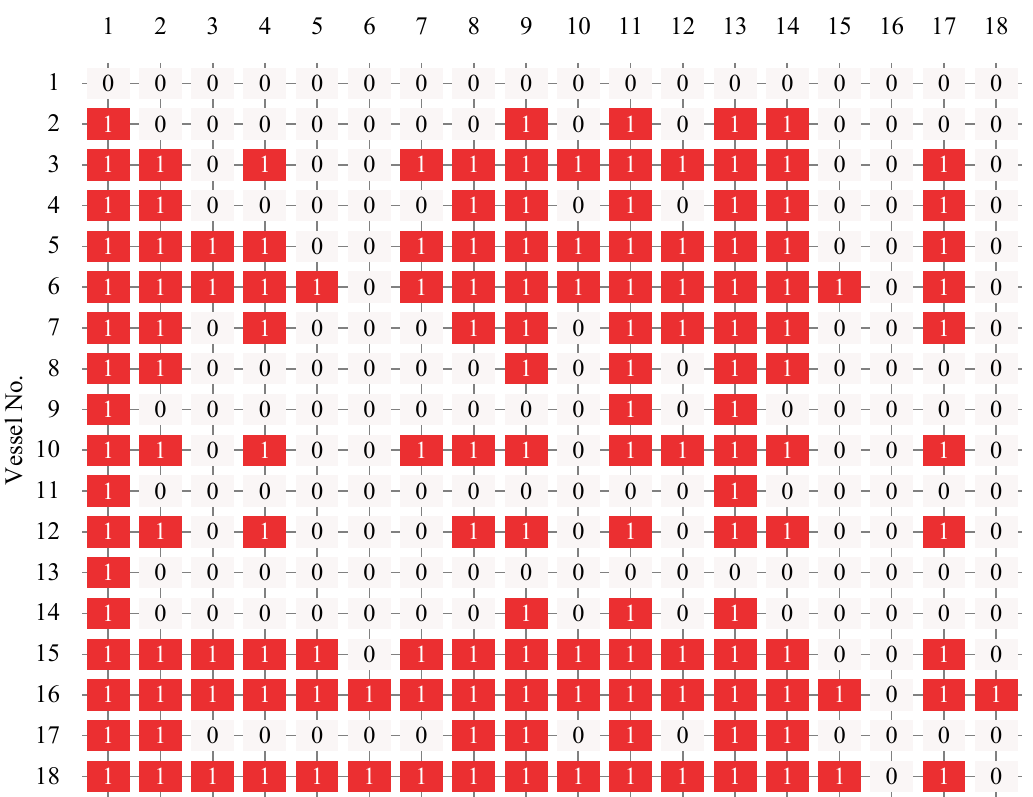
Figure 14. The result of decision variable of instance “Inst_18_1”.